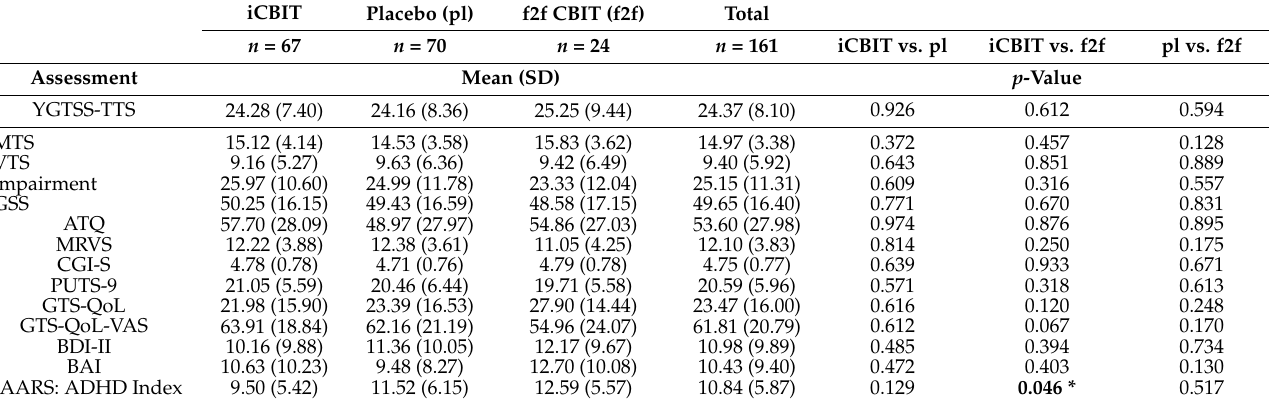
Table 2. Baseline characteristic: clinical